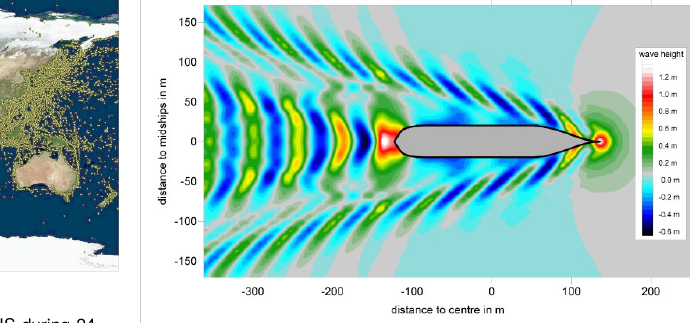
Figure 2. Wavesystemofacontainership, length280m, width40m, draft 11 m at a speed of 9 m/s. Data derived from CFD calculations by